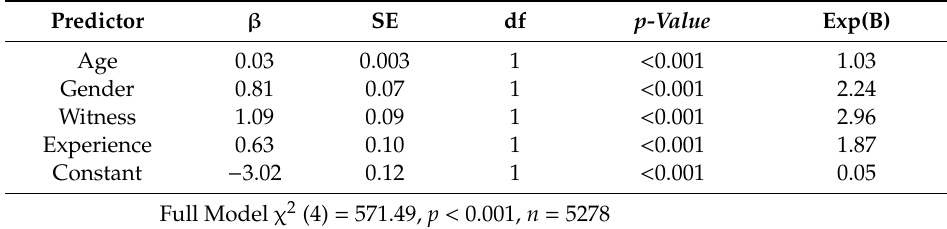
Table 2. Logistic Regression for RHS-15 positive